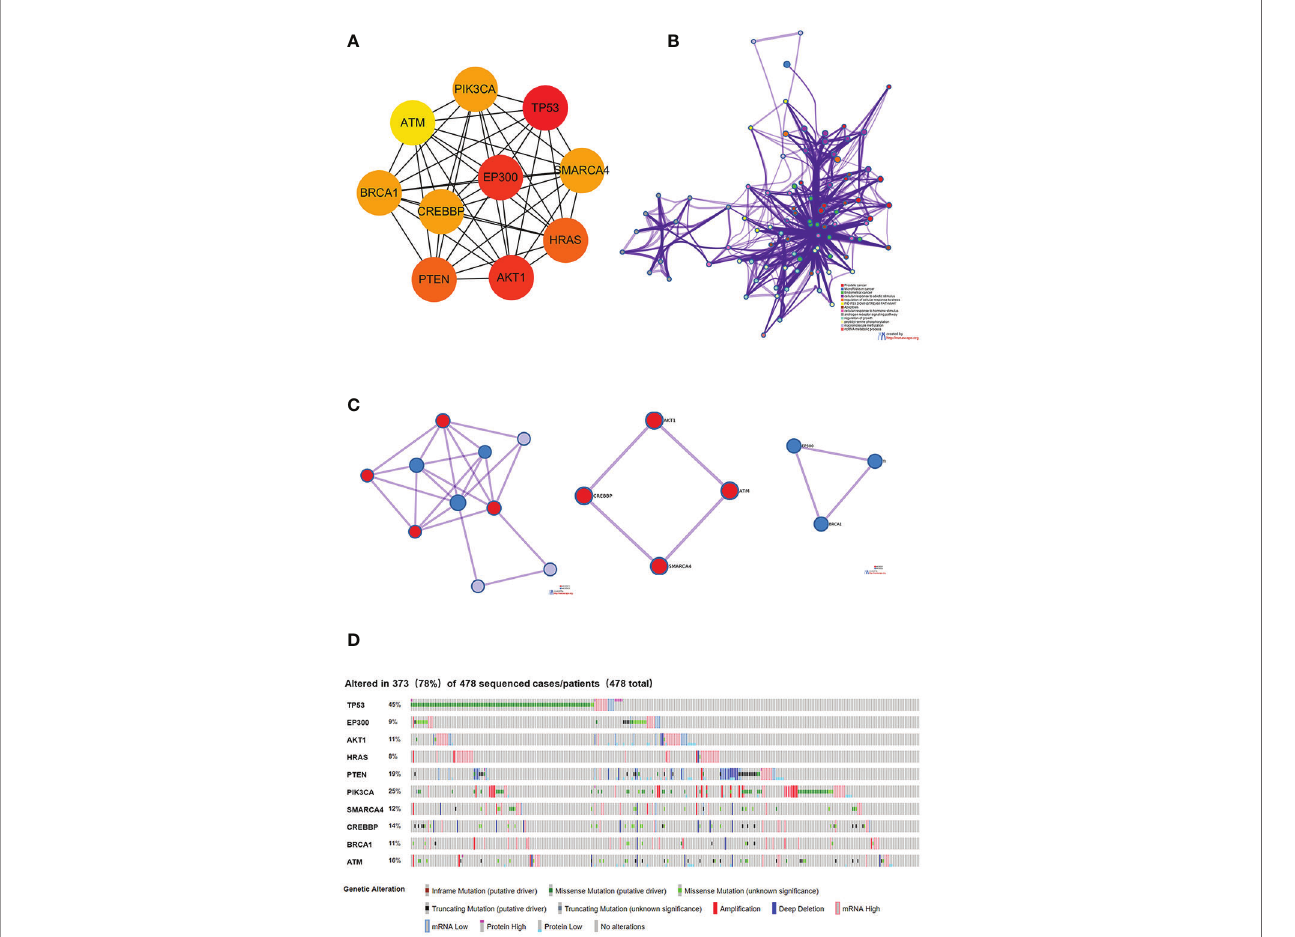
FIGURE 6 | Selection and analysis of pivotal genes. (A) Identi fi cation of the 10 most important central genes using the Cytoscape software plug-in cytoHubba. (B) Metascape tools were used to analyze the pathway and biological process enrichment of hub genes. (C) Protein-protein interaction network and MCODE components identi fi ed in the gene lists. (D) Graphic analysis of the genetic alteration of key